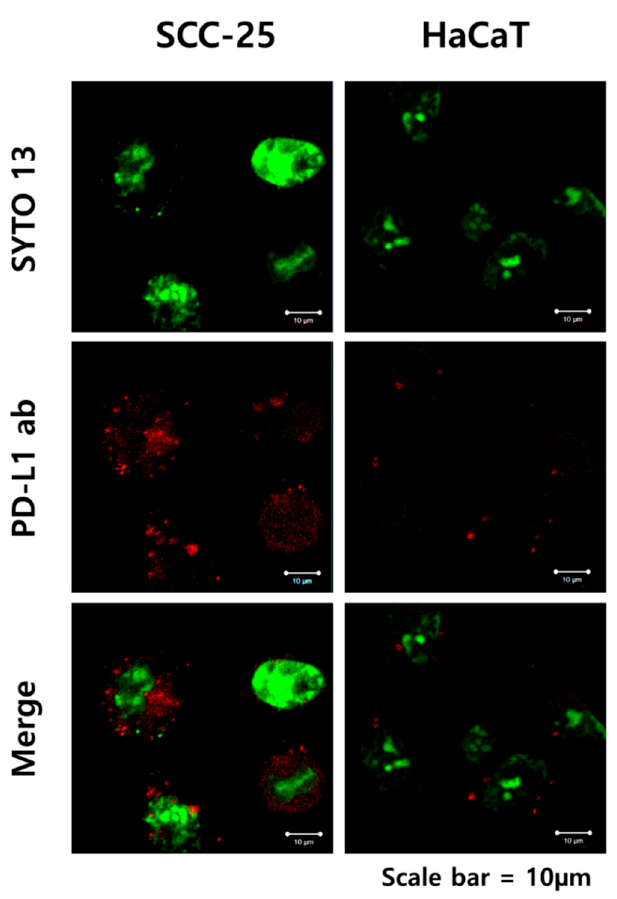
Figure 3. Cellular expression of PD-L1 and uptake of PD-L1 ab + GNP. Green spots represent a cell nucleus. Red spots represent PD-L1 ab + GNP bound on SCC-25 cells. Abbreviations: NT, nontreatment; ab, antibody; GNP, gold